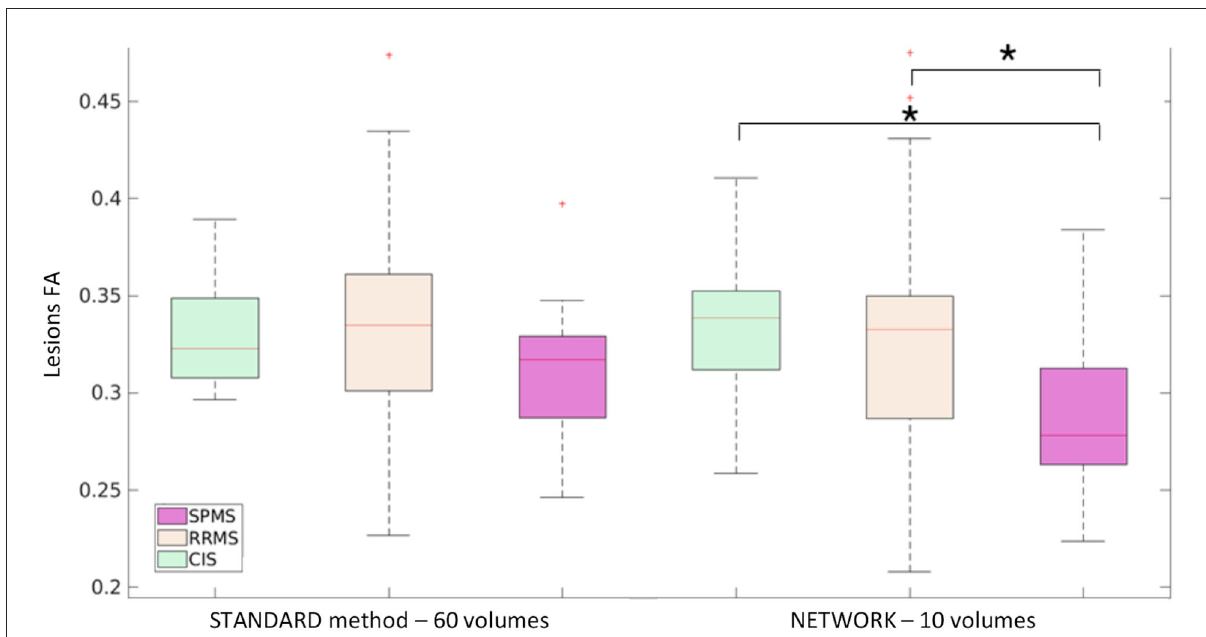
FIGURE9 Boxplot of mean fractional anisotropy (FA) values in lesions for MS patients: subjects divided by group clinical isolated syndrome (CIS), relapsing—remitting MS (RRMS), and secondary progressive MS (SPMS) considering the mean value lesion FA of the ground truth (STANDARD method − 60 volumes) and of the network (NETWORK − 10 volumes). Significant differences are indicated with an asterisk ( p <